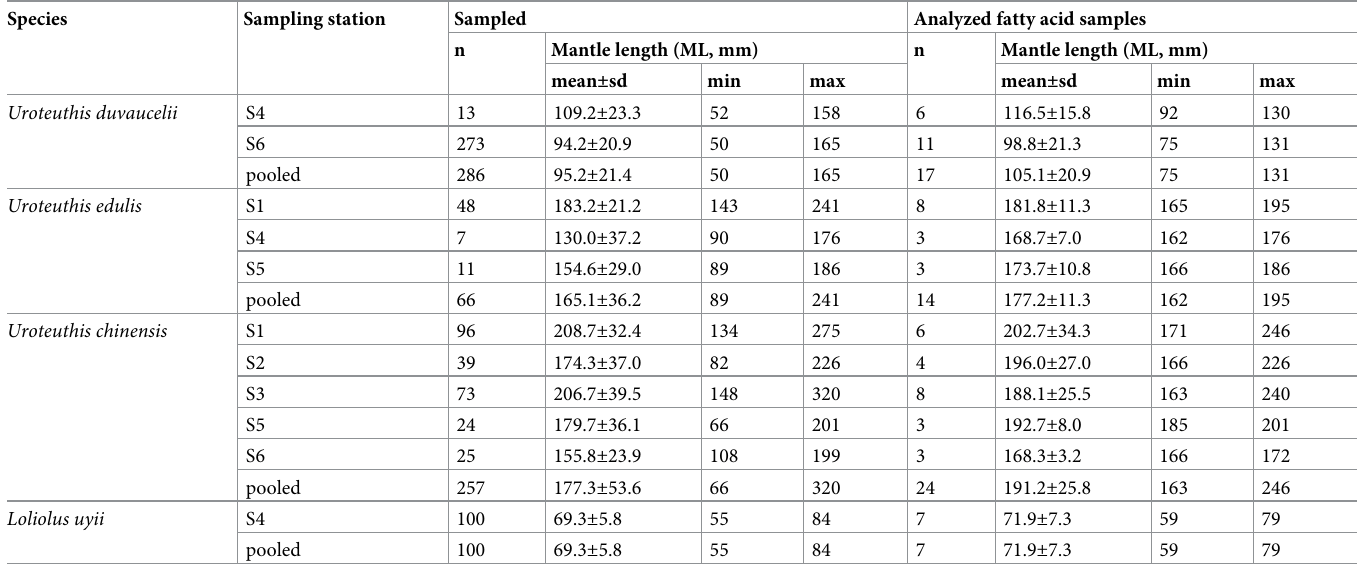
Sampling station corresponds to the stars in Fig